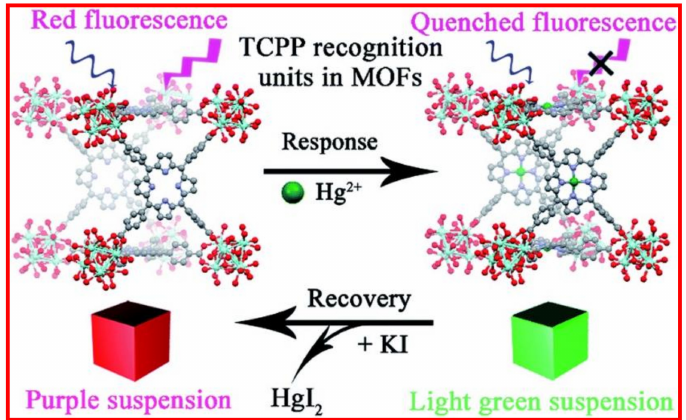
Figure 2. Illustration of the sensor construction protocol. The inherent TCPP linker was designed as the recognition site as well as the signal reporter for Hg 2+ sensing at the same time. Upon the addition of solution into the PCN-224 -Hg 2+ system, analytes were disassociated and fluorescence of PCN-224 was recovered while the visual colour also turned from light green to purple (Reproduced with the permission from Ref